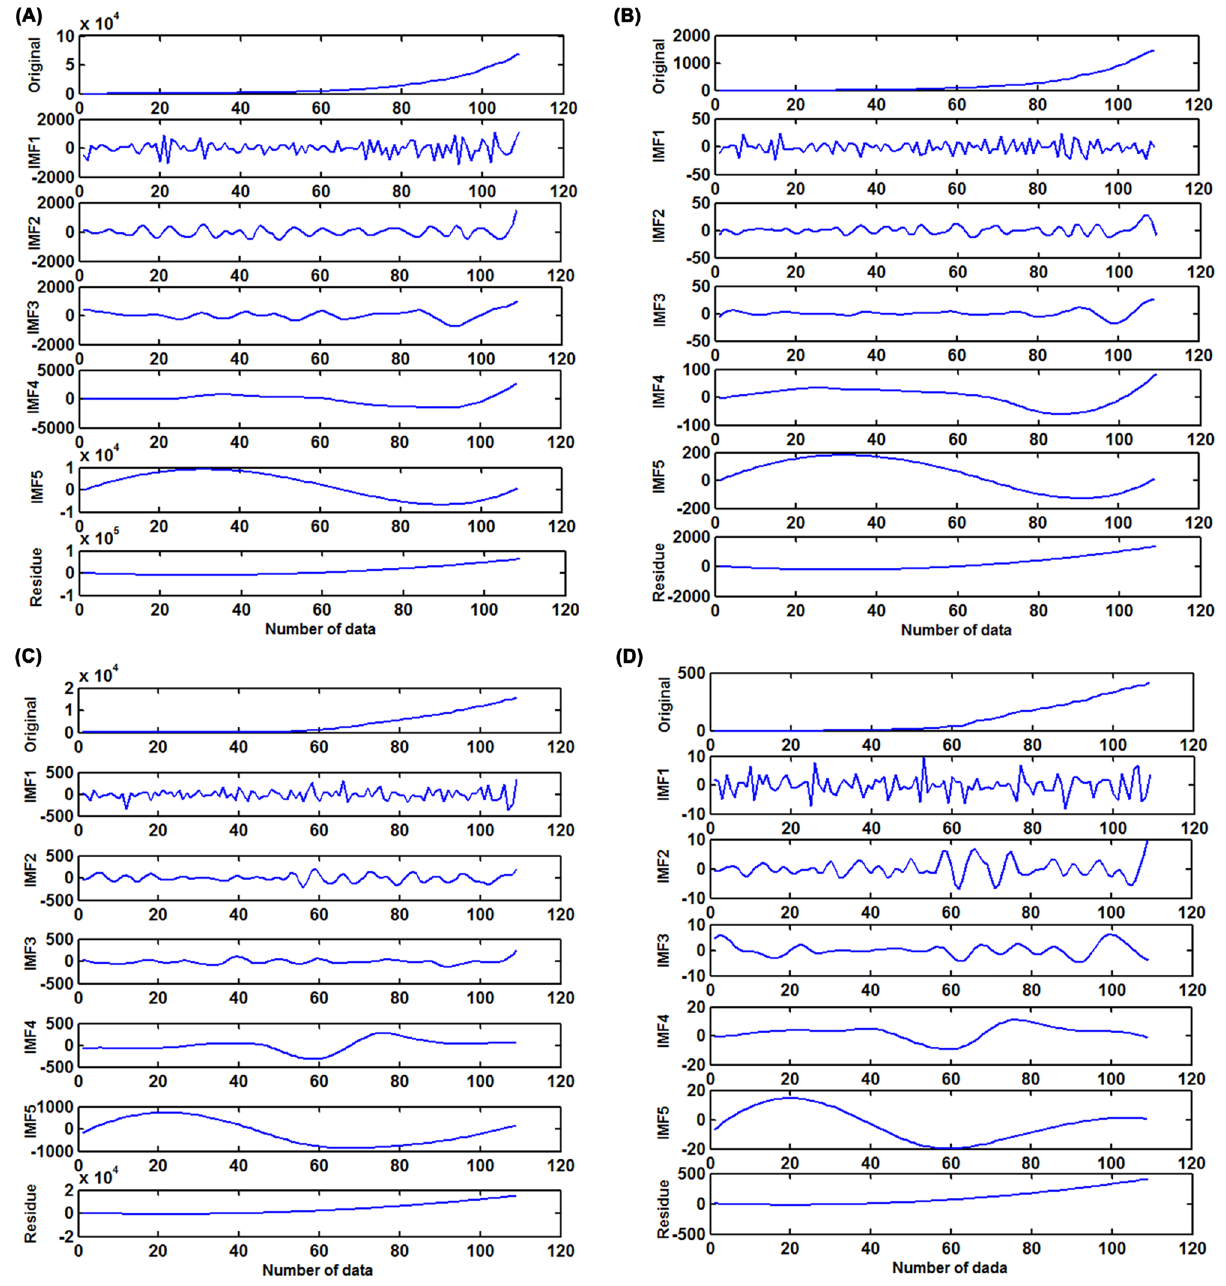
Figure 6. Intrinsic Mode Functions (IMFs) subseries via decomposing the original prevalence and mortality time series. ( A ) The resulting IMFs subseries by decomposing the prevalence series in South Africa; ( B ) The resulting IMFs subseries by decomposing the mortality series in South Africa; ( C ) The resulting IMFs subseries by decomposing the prevalence series in Nigeria; ( D ) The resulting IMFs subseries by decomposing the mortality series in